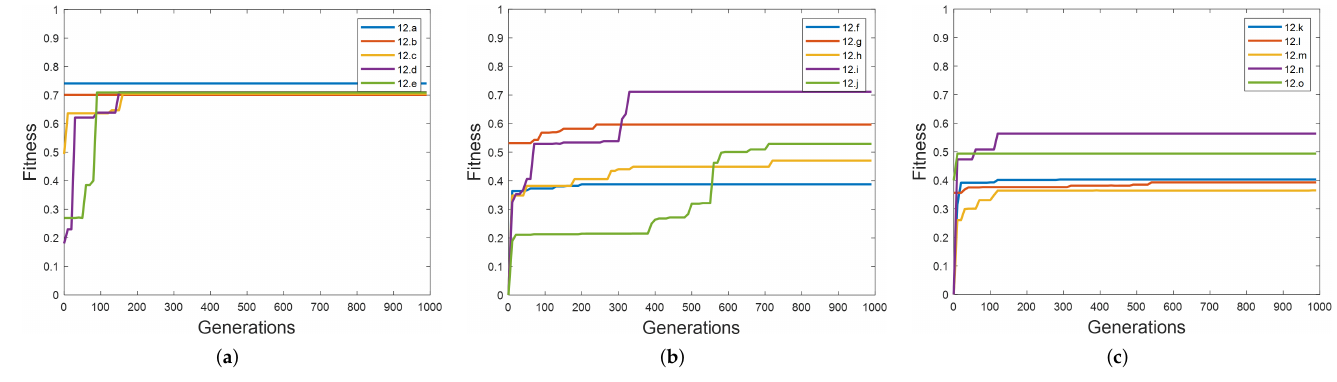
Figure 13. Fitness evolution trend of the elite individual by running the detection system once on synthetic images ( a ), real images with circular objects ( b ), and real images of hand-drawn figures ( c ).